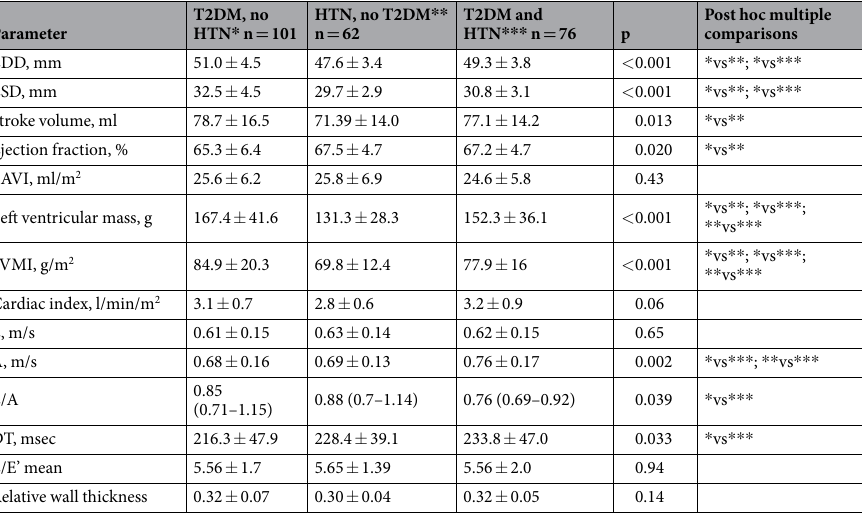
Table 2. Echocardiographic parameters. ANOVA; Data is presented as means ± SD, median [25–75th percentile], or percentages; T2DM-type 2 diabetes, HTN-hypertension; EDD-left ventricular end diastolic diameter, ESD-left ventricular end systolic diameter, LAVI-left atrial volume index, LVMI-left ventricular mass index, E-early mitral valve flow velocity, A-late mitral valve flow velocity, E/A-ratio of early to late mitral valve flow velocity, DT-deceleration time, E/E ′ -ratio of early mitral valve flow velocity to early Tissue Doppler lengthening velocity.